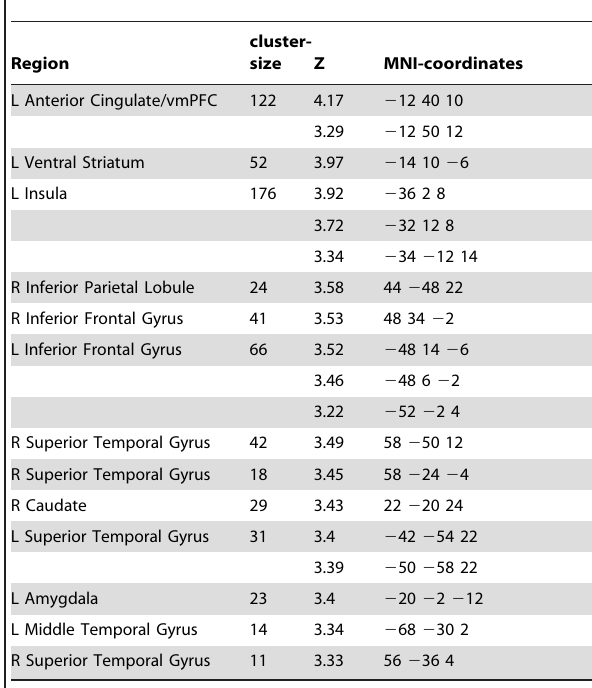
Table 3. Anatomical Site, Cluster Size, maximum Z value, and MNI coordinates of the local maxima for the connectivity analysis (seed in right ventral striatum [MNI coordinates 10 10 2 2], connectivity gamblers . controls, main effect across delay and probability discounting trials).